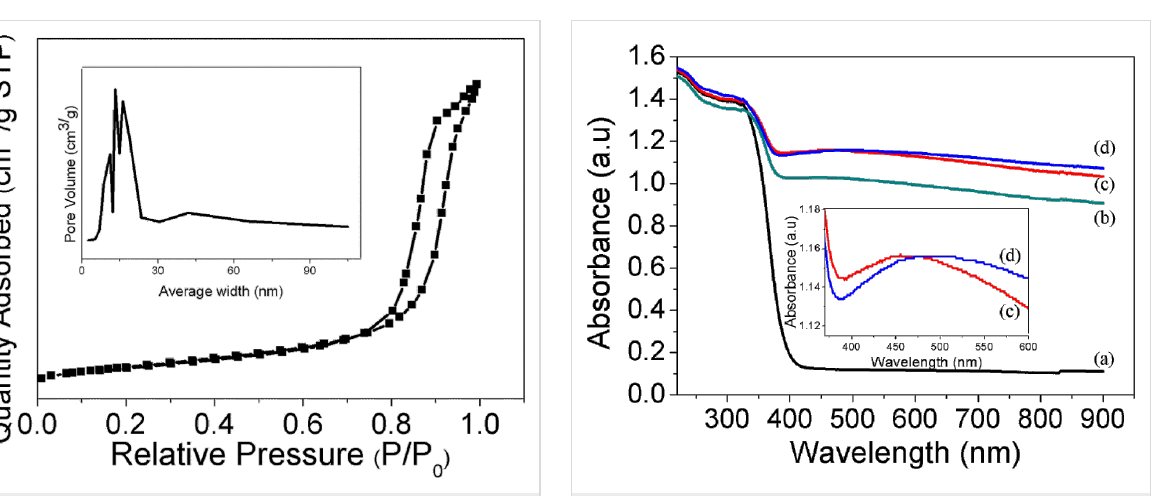
shown by anatase TiO 2 sample due to the